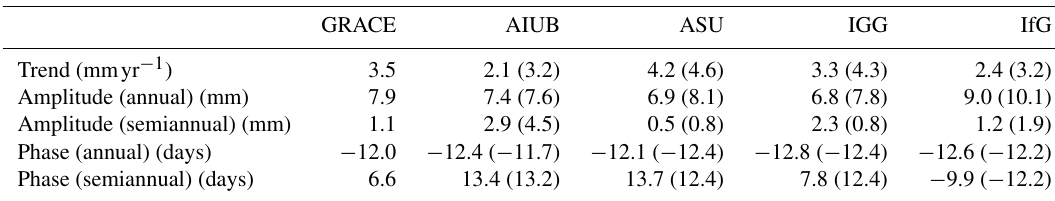
Table 7. Comparison of Swarm solutions from different institutes measuring trend, amplitude, and phase. The values in parentheses indicate the results for the exact same months that are available for GRACE, while the values without parentheses are computed from the whole Swarm time series. The results are based on the time series of Fig. 2.